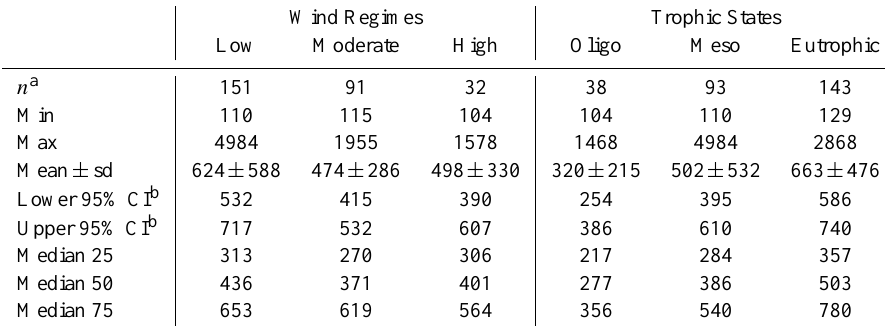
Table 4. Statistical data on surfactant concentrations in the microlayer at different wind regimes and trophic states. Wind Regimes Trophic States Low Moderate High